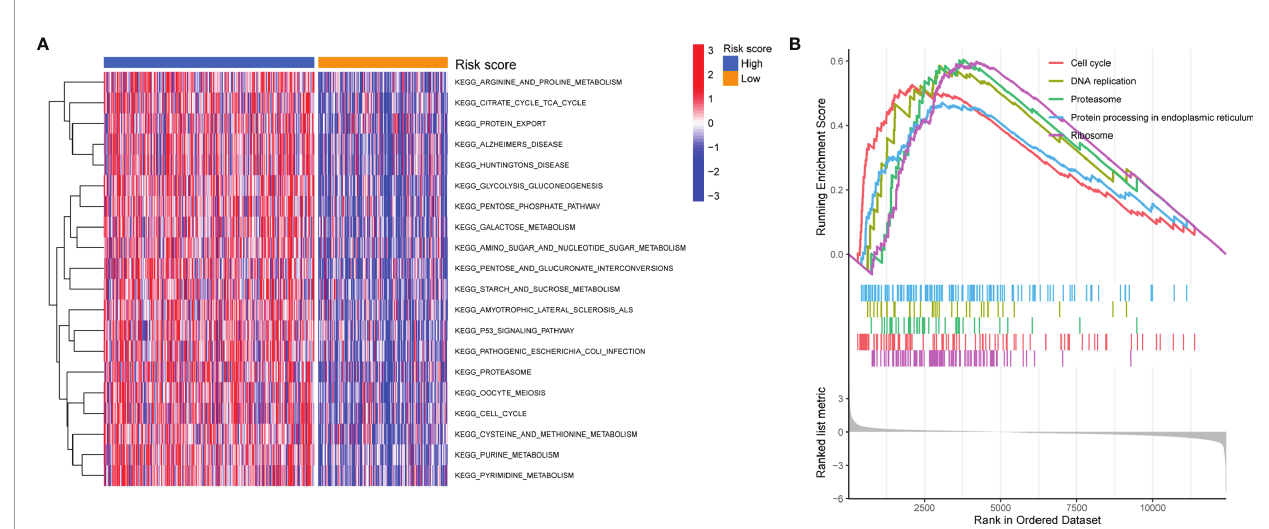
FIGURE 7 | Pathway Enrichment Analysis. (A, B) GSVA and GSEA of biological pathways between the high- and low-risk group.